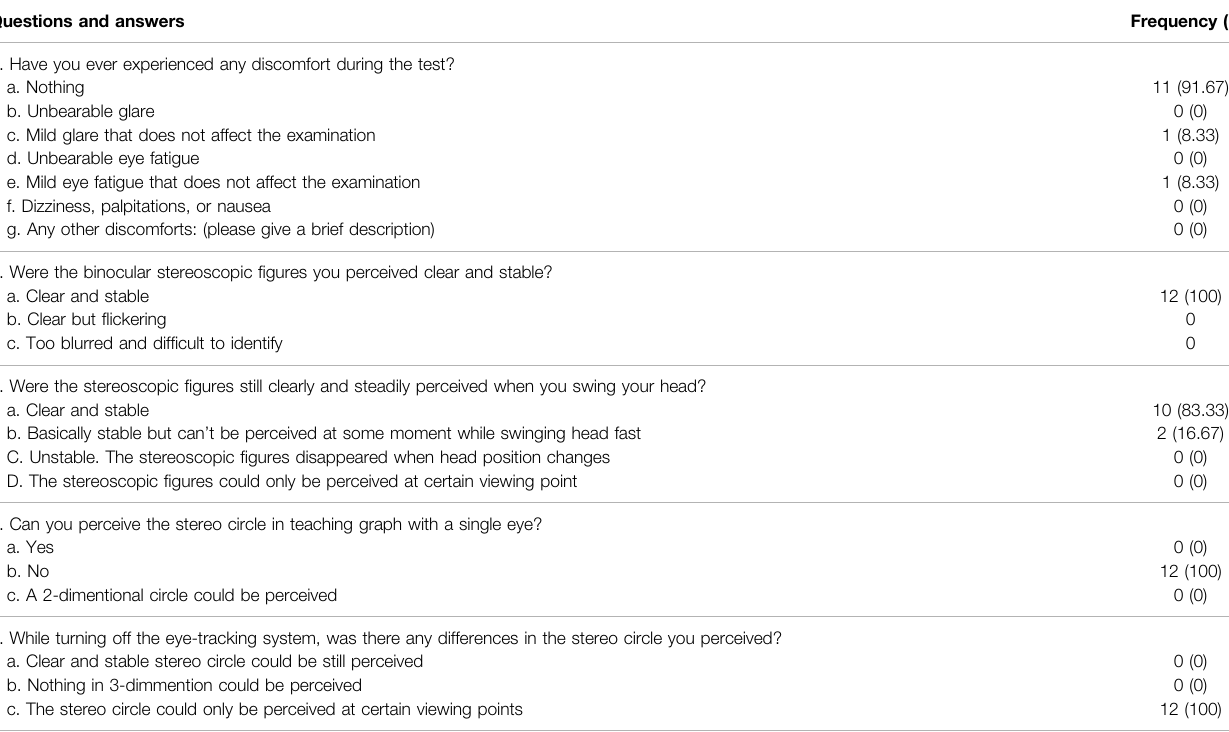
TABLE 2 | Results of questionnaires from subjects after GFDRDSS